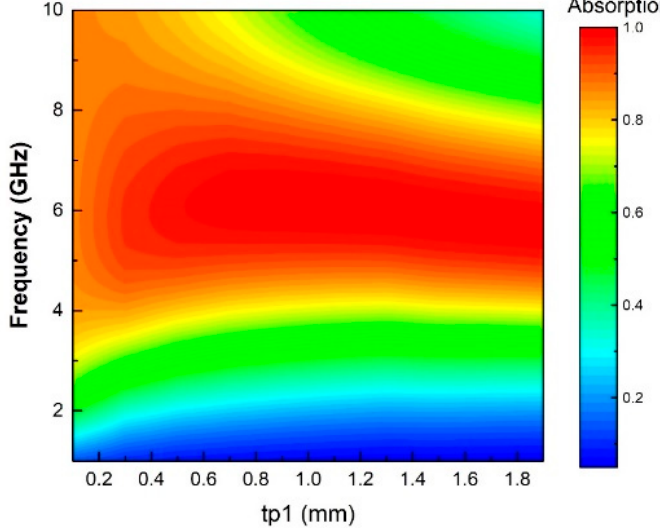
Figure 6. Absorption spectra by varying the thickness of polyimide 1.